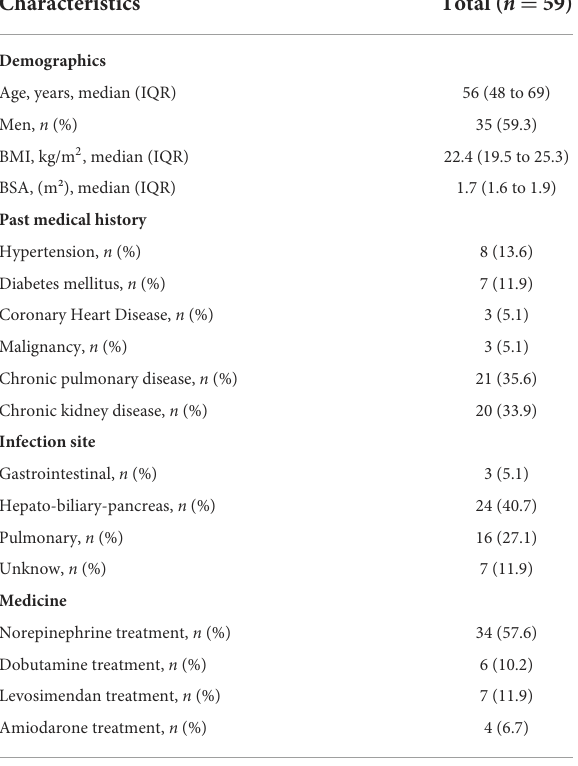
TABLE 1 Demographics and baseline characteristics of patients.